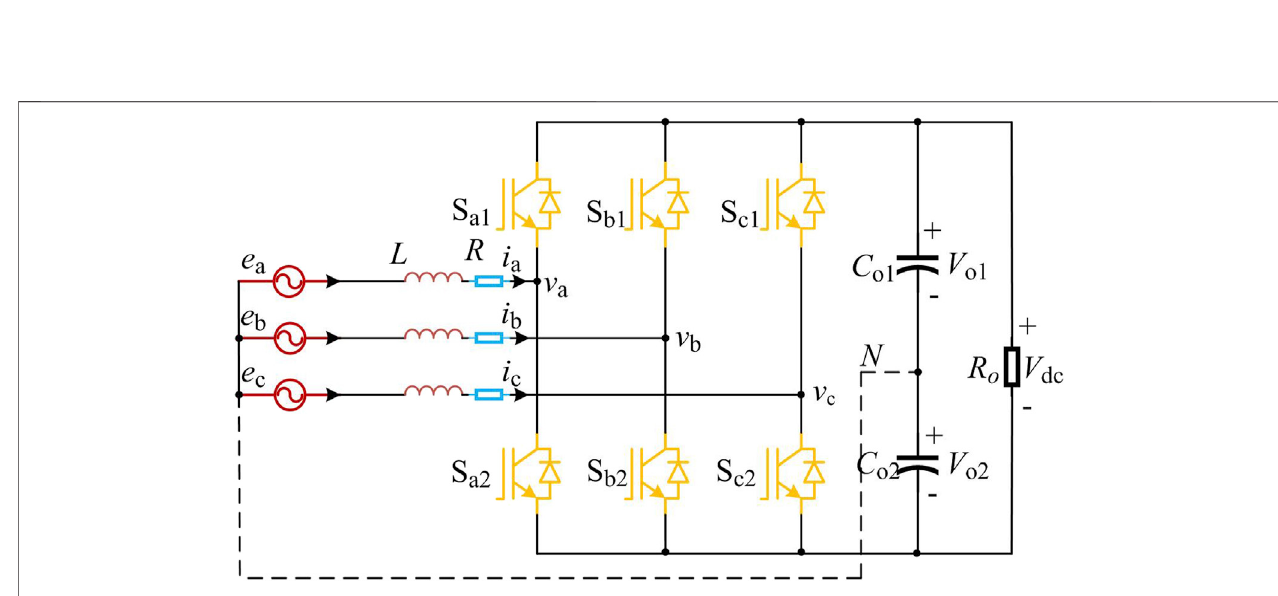
FIGURE 2 | Main circuit topology of the three-phase PWM VSR.